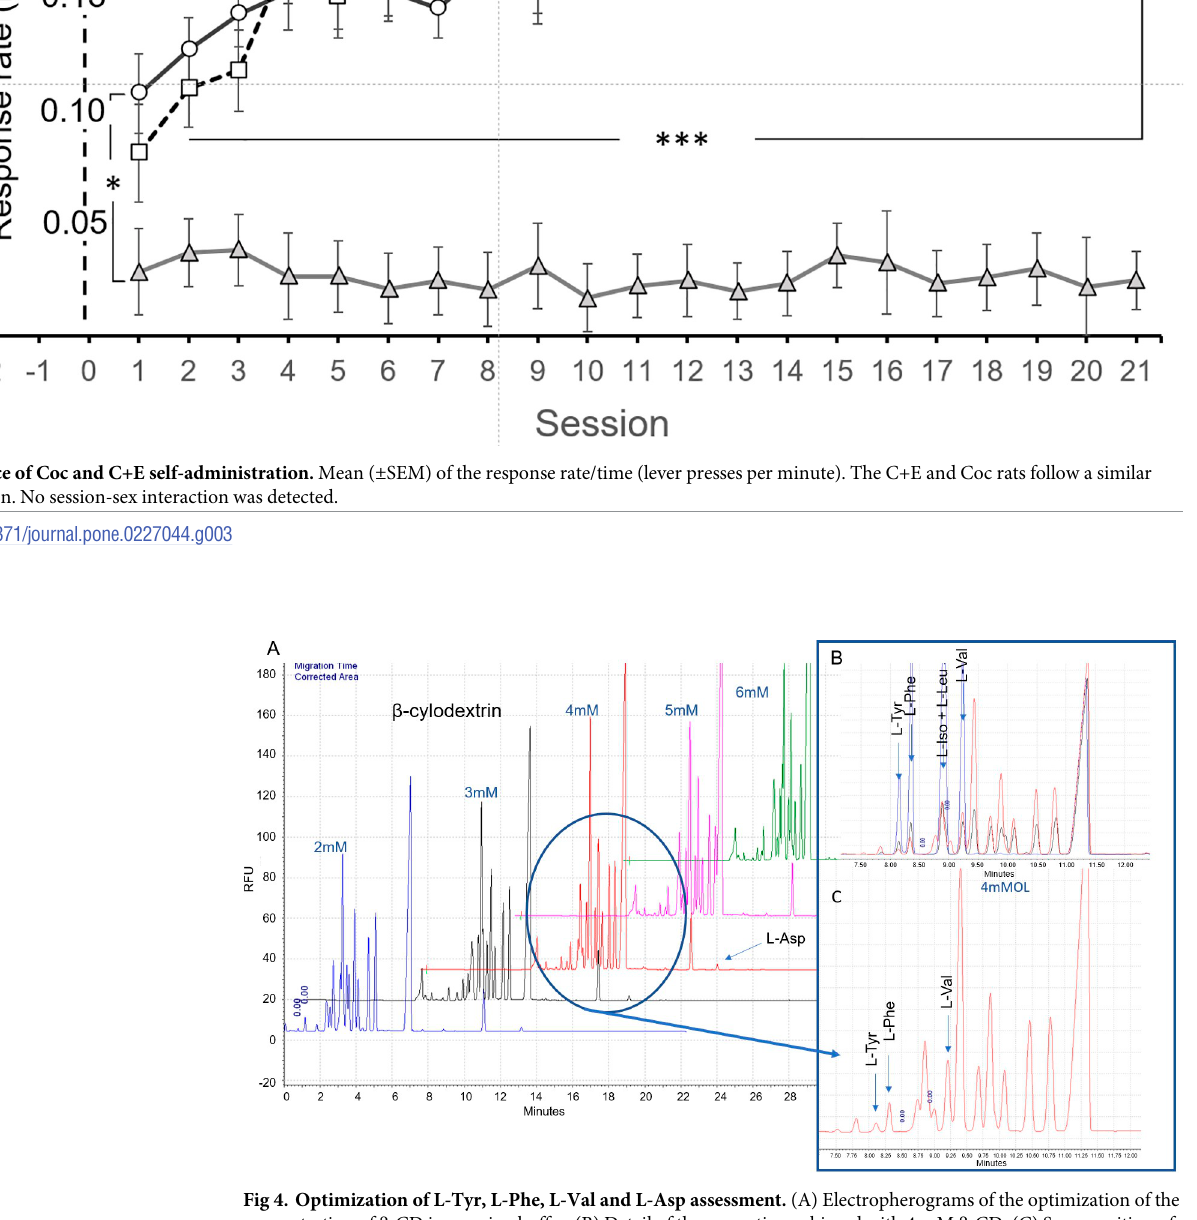
PLOS ONE | https://doi.org/10.1371/journal.pone.0227044 March 23,